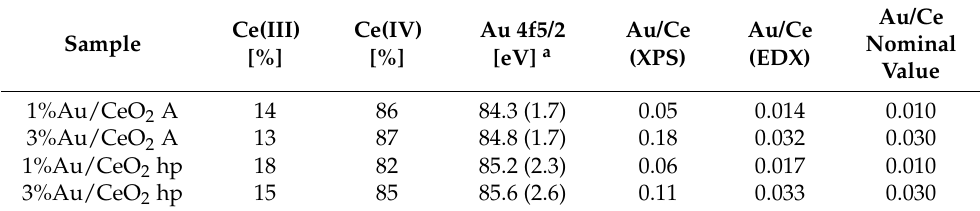
Figure 6. ( A ) Ce3d XP spectrum of 1%Au/CeO 2 A and ( B ) Au 4f XP spectra of all Au supported catalysts. Table 2. XPS data of the two series of Au/Ceria catalysts in terms of Ce(III)/Ce(IV) percentages, Au 4f5/2 binding energy and Au/Ce atomic ratios. The values calculated by EDX and the nominal Au/Ce ratios are reported for